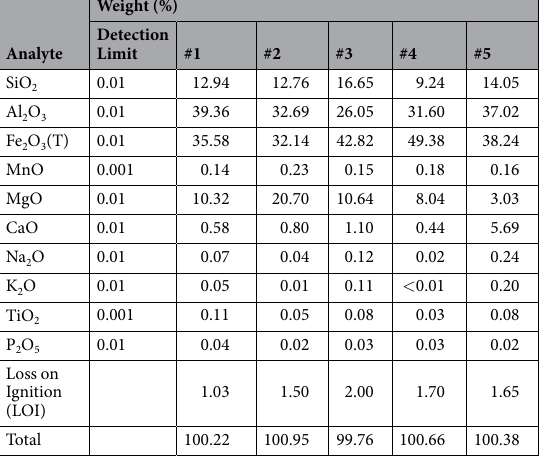
Tested material